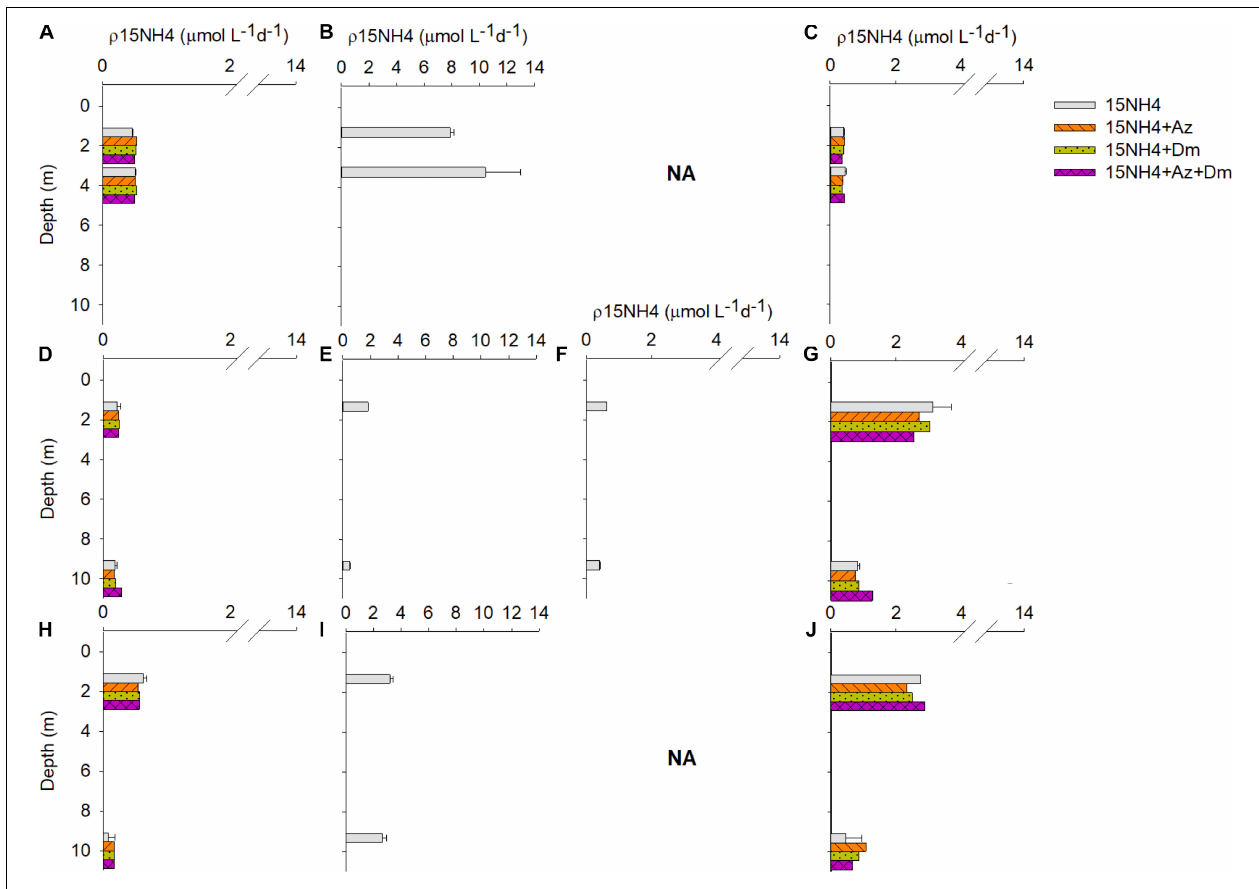
FIGURE 4 | In situ ammonium uptake rates ( µ mol L − 1 d − 1 ) profiles at Llico Bay. Upper panels for Bll1 station, middle panels for Bll2 and lower panels for Bll3 station. (A,D,H) Winter 2015; (B,E,I) Spring 2015; (F) Summer 2016; (C,G,J) Autumn 2016. NA are not available data for Bll1 and Bll3 station in Summer 2016. Errors bars represent the standard deviations.